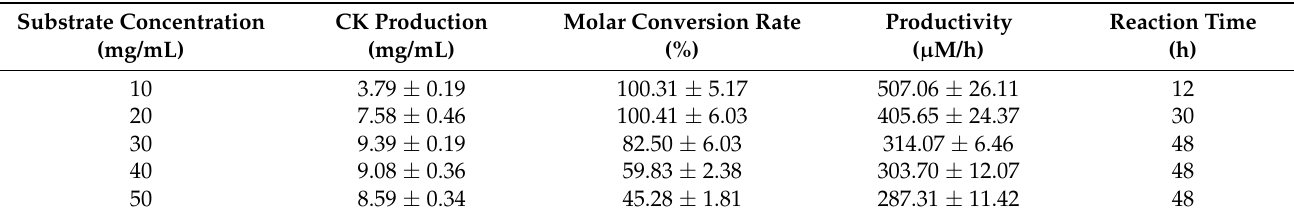
Table 1. Effect of substrate concentration on ginsenoside